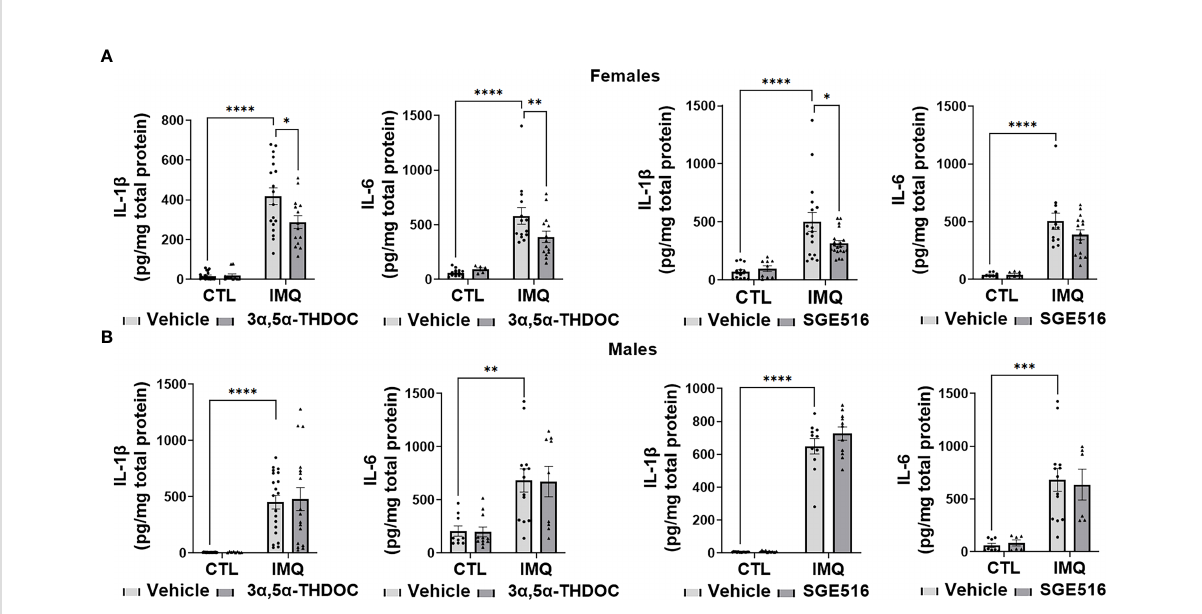
FIGURE 8 3 a ,5 a -THDOC partially inhibits imiquimod-induced increases of IL-1 b and IL-6 and SGE-516 partially inhibits IL-1 b in human monocyte-derived macrophages (hMDM) from female but not male donors. Each hMDM culture (n ≥ 12 from 3 female (A) or 3 male (B) donors/grp) is shown as a single symbol. Cells were treated with imiquimod (IMQ) (30 µg/ml; 24h) with or without 3 a ,5 a -THDOC (1µM; 24h) or SGE-516 (1µM; 24h). IMQ caused a signi fi cant increase in the levels of IL-1 b (~95% in hMDM from both female (A) and male (B) donors) and IL-6 (~90% and ~80% in MDM from female (A) and male (B) donors, respectively) relative to vehicle control (CTL). The increases of IL-1 b were partially inhibited by 3 a ,5 a - THDOC and SGE-516 (~30% and ~35% inhibition, respectively) in hMDM derived from female (A) but not male (B) donors. The increases of IL-6 were partially inhibited by 3 a ,5 a -THDOC in hMDM from female (~30% inhibition) (A) but not male (B) (p>0.05) donors and were not inhibited by SGE-516 in hMDM from both female (A) and male (B) donors (p>0.05). Two-way ANOVA, Tukey ’ s post hoc test: *p<0.05, **p<0.01, ***p<0.001,